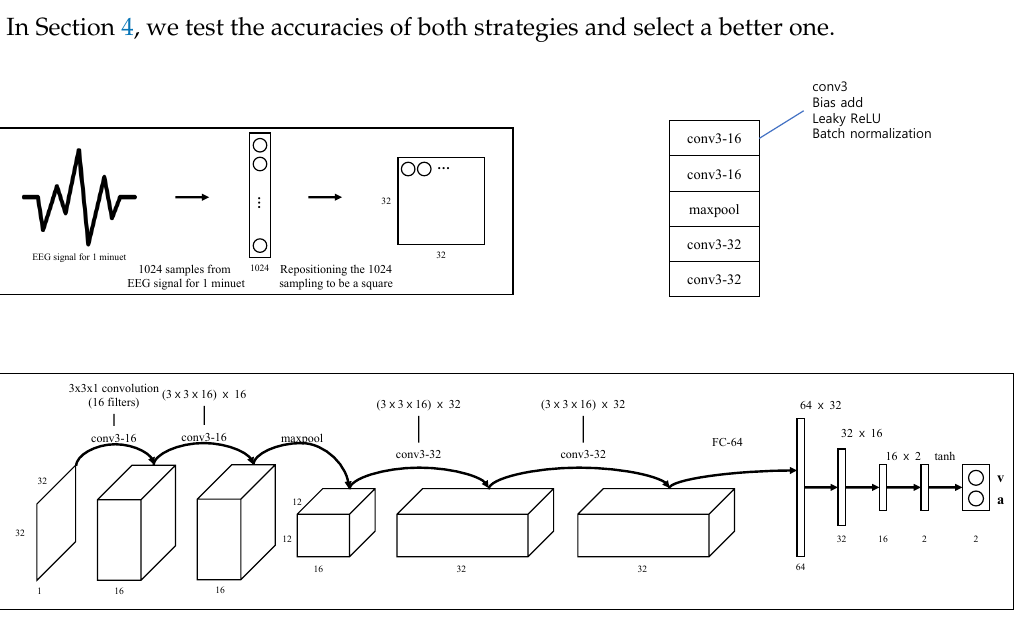
Figure 2. A recognizing module for EEG signal. We sample 1024 discrete values from an EEG signal of DEAP dataset. The sampled values are reformulated to 32 × 32 rectangular form, which is fed into our CNN-based recognizing